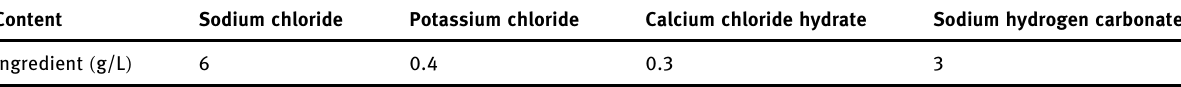
Table 1: Chemical composition of the Ringer ’ s solution Content